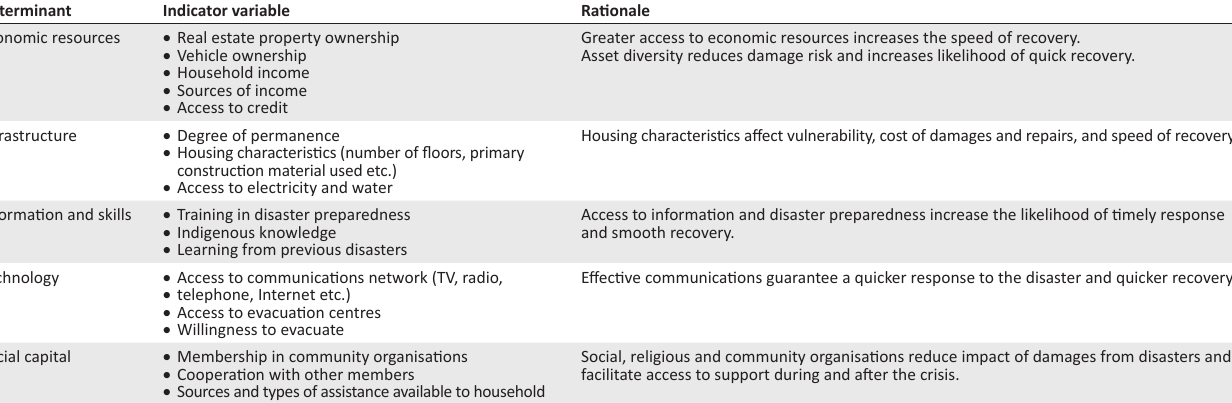
TABLE 1: Determinants of recovery. Determinant Indicator variable Rationale Economic